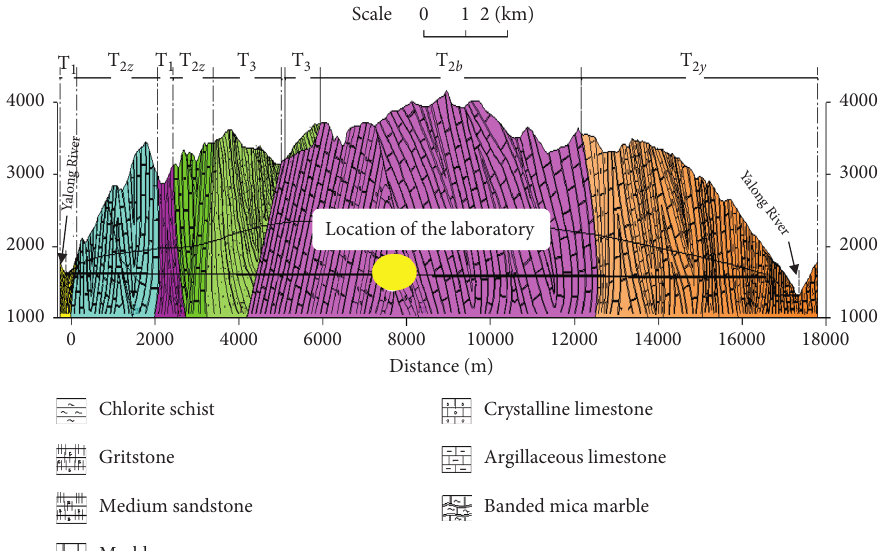
Figure 9: Location of Jinping deep underground